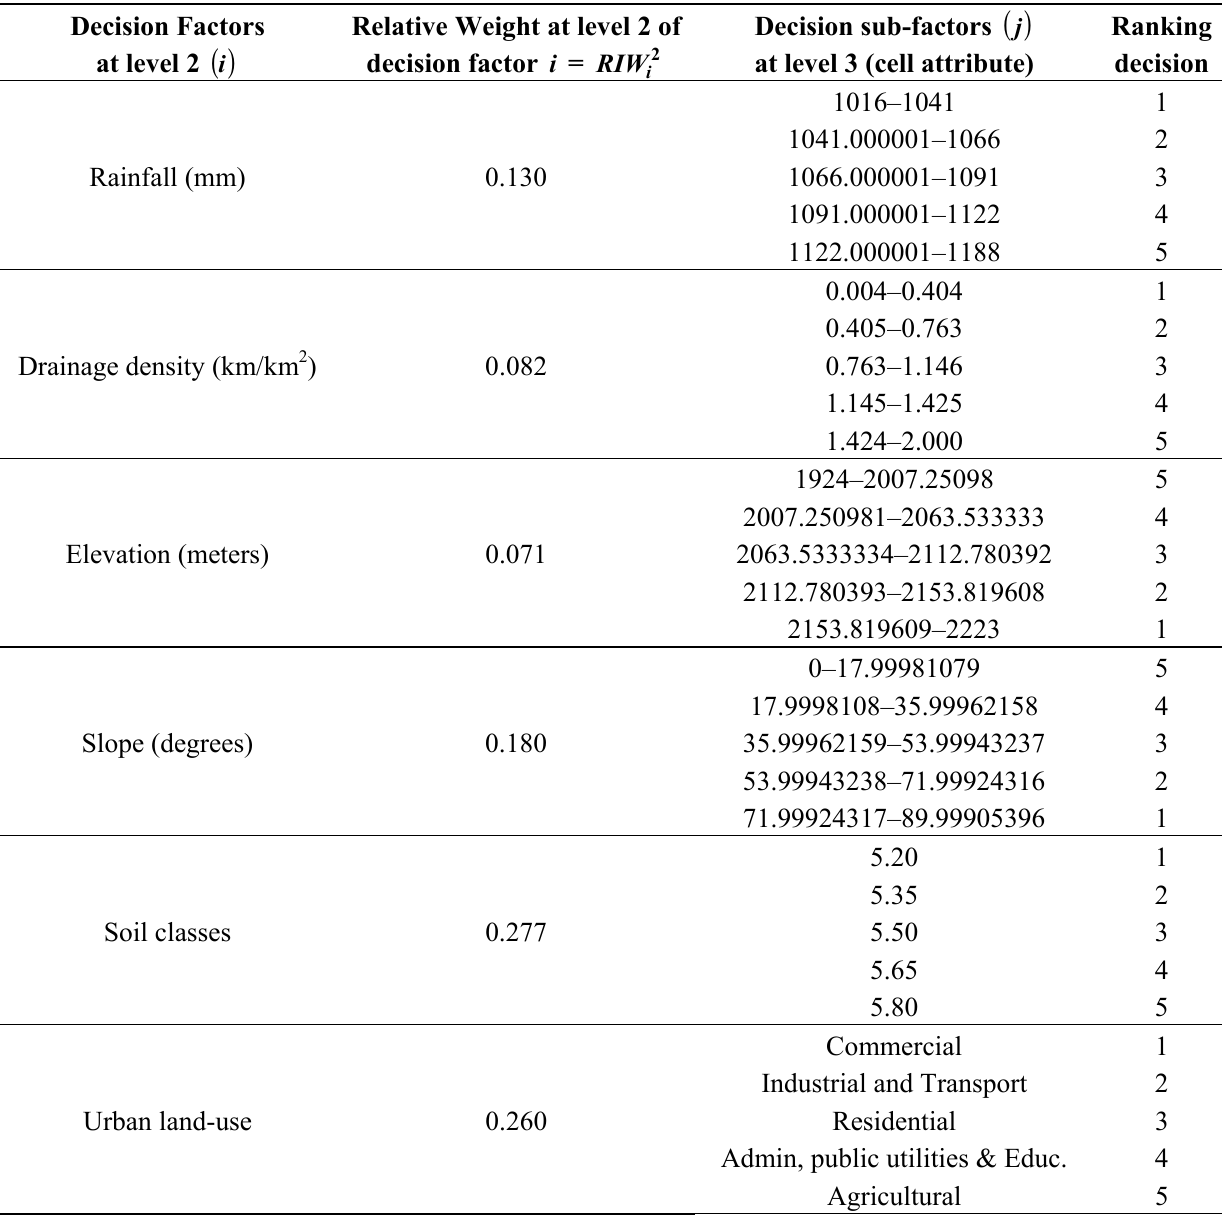
Table 5. Weighted flood hazard ranking for the case